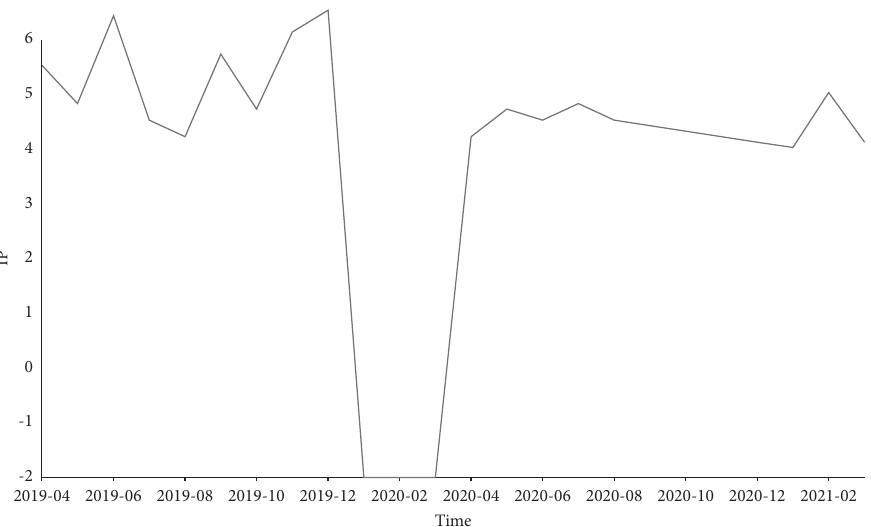
Figure 5: Forecast value of industrial added value growth rate in 12